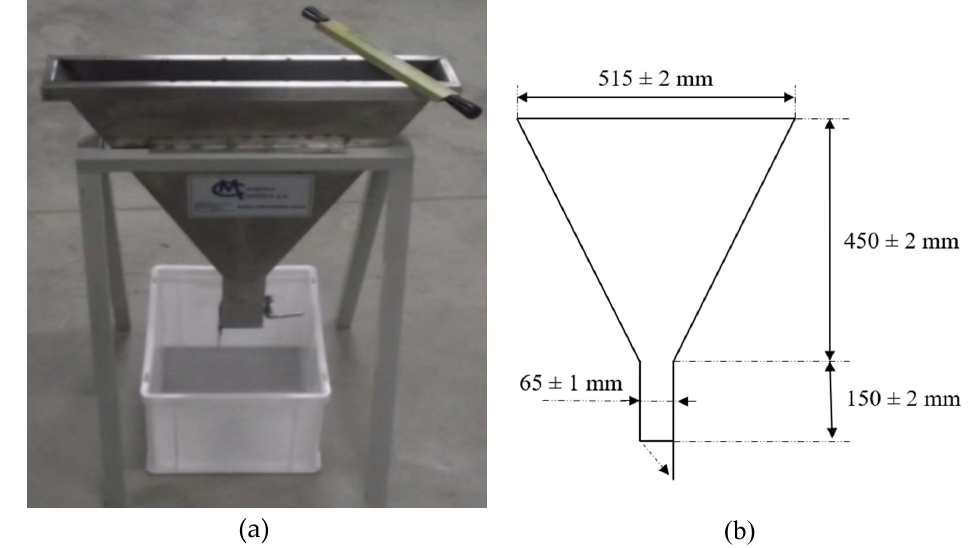
Figure 5. (a) Assembly for V-funnel test; (b) V-funnel dimensions.